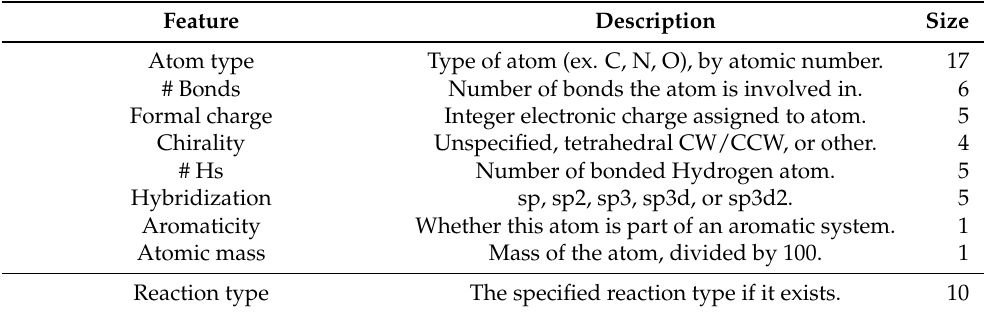
Table A4. Atom features used in our method. All features are one-hot encoding, except the atomic mass is a real number scaled to be on the same order of magnitude. The reaction type is applicable for type conditional